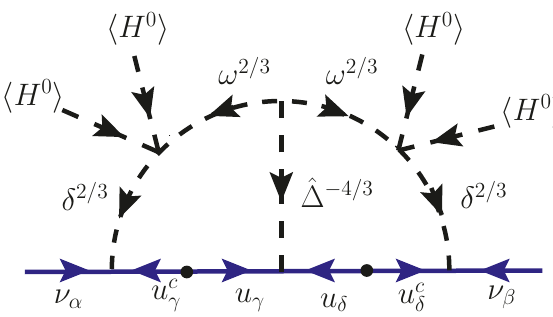
3 or table 5 [31]. 8 O